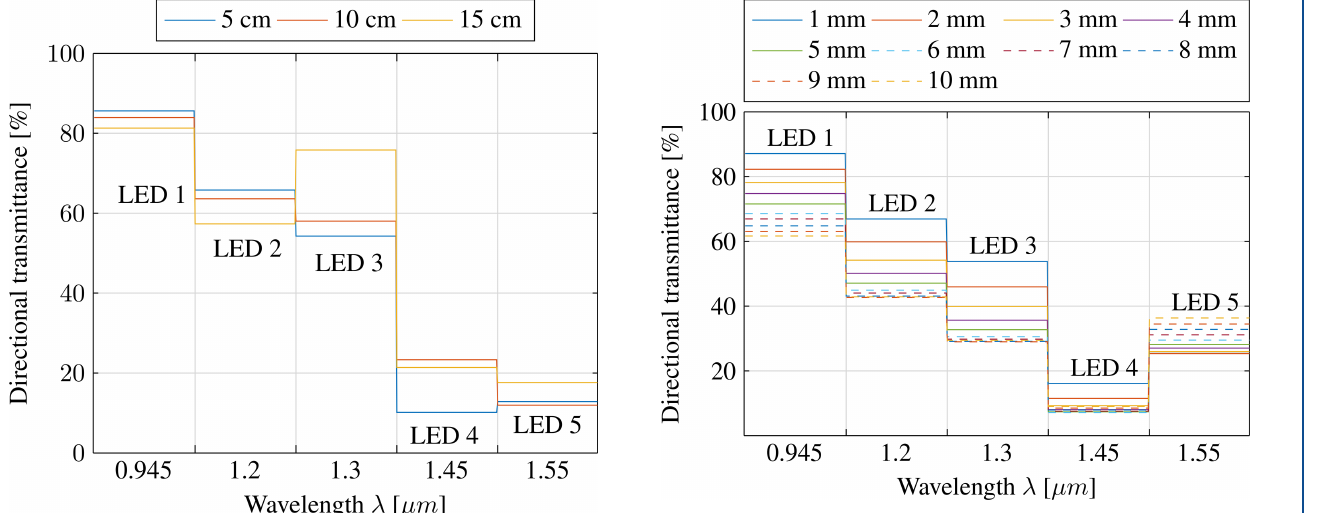
Figure 11. Transmittance at a water film height of 1mm for differ- ent distances with a white tile surface.